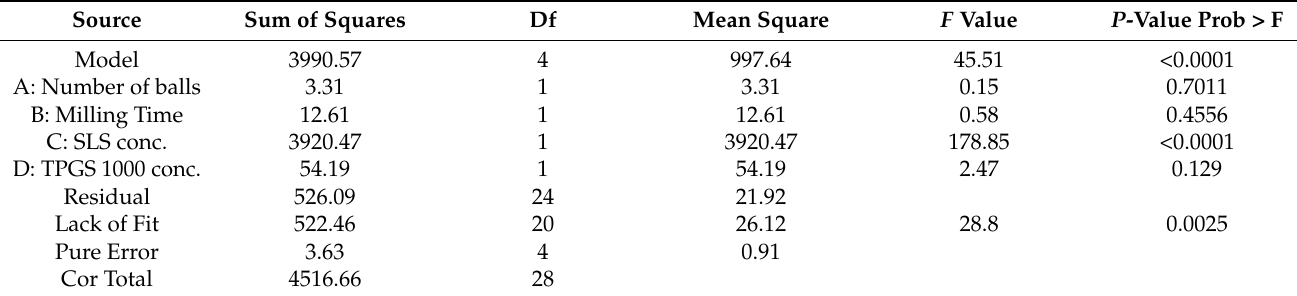
Table 6. ANOVA data for the response surface linear model for ZP.